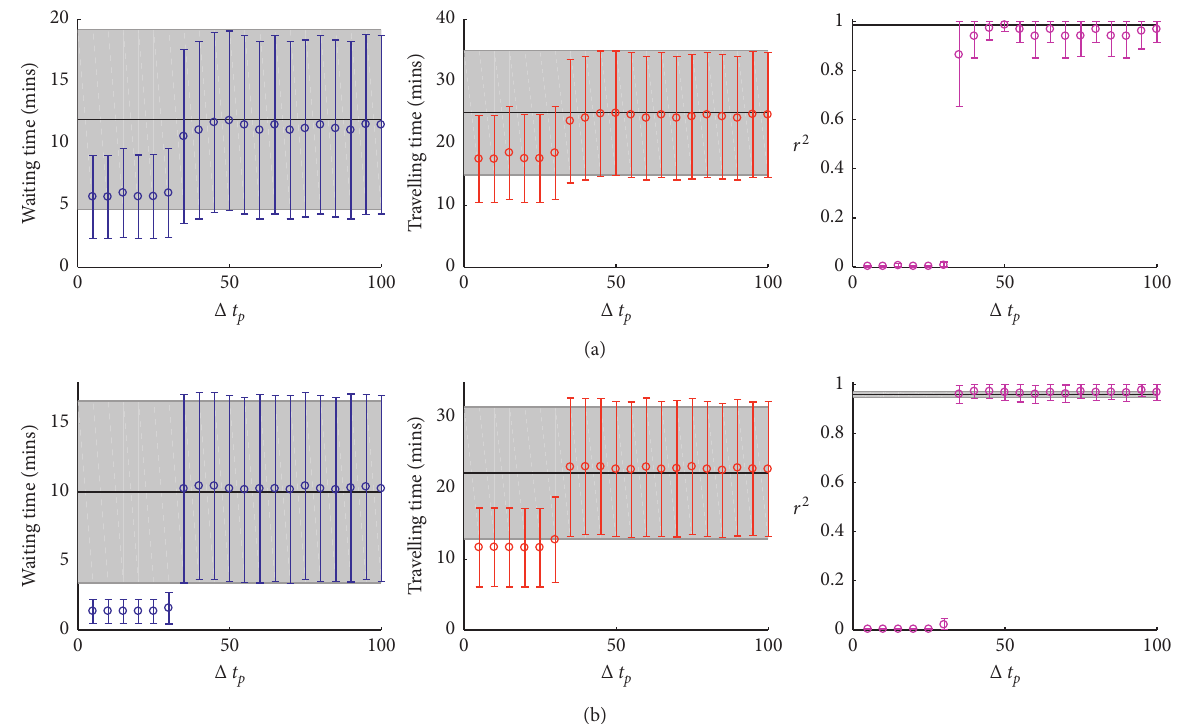
Figure 10: Results of the centralized-pulsing strategy on the two same-velocity scenarios. Each colored point represents the mean and standard deviation of the measured quantities calculated from 100 realizations of each parameter value. The black line and grey shaded area of each graph denote the mean and standard deviation of the measured quantities from a control case, which are simulation runs of the same parameter values, without any intervention